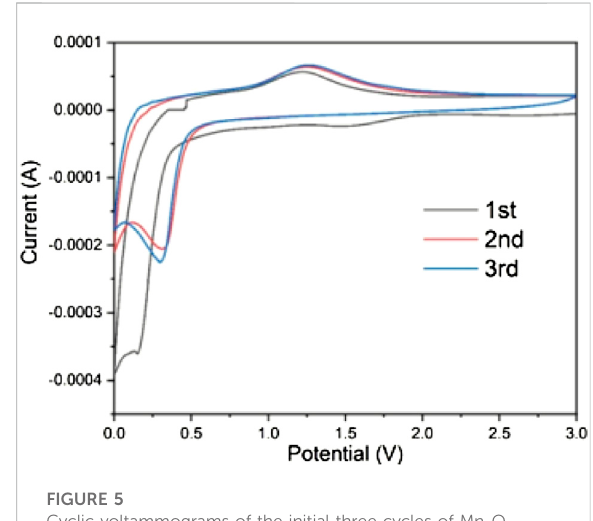
FIGURE 5 Cyclic voltammograms of the initial three cycles of Mn 3 O 4 . (scan rate 0.1 mV s −